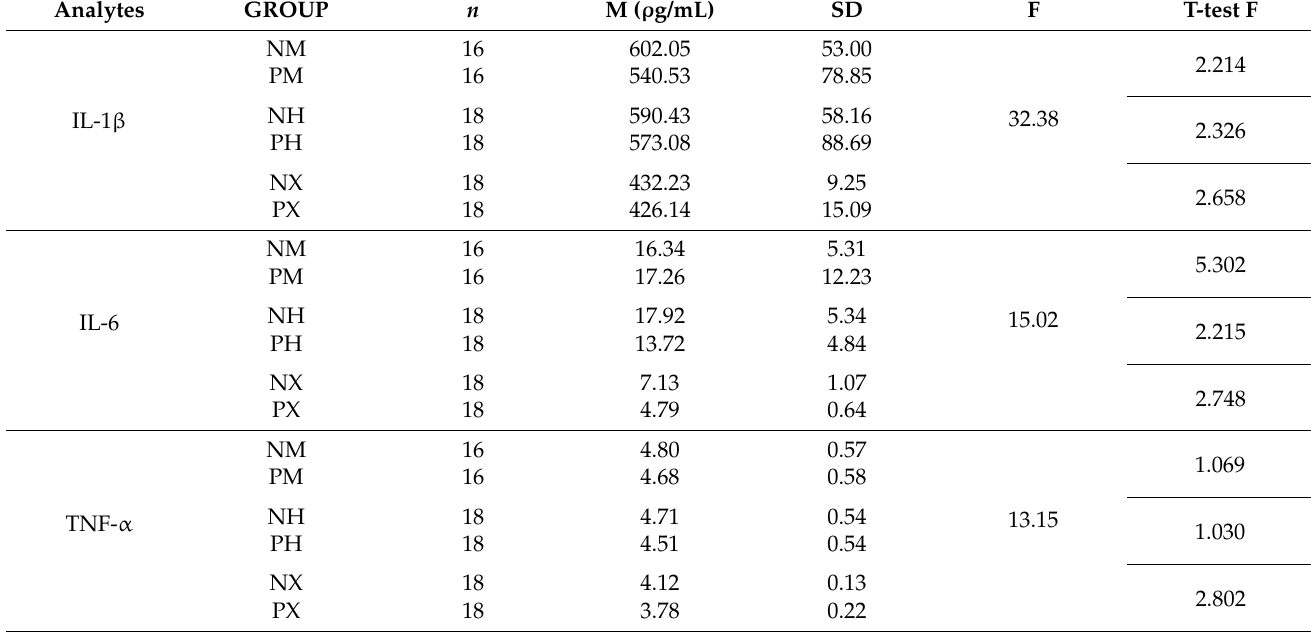
Table 3. Statistical values of cytokines for the concentrations of IL-1 β (left panel), IL-6 (middle panel), and TNF- α (right panel) in cerebellar lysate from mice brains. Cytokines were detected by ELISA. Values are presented as M (mean, pg/mL) and SD (Standard Deviation). N, no probiotics; P, probiotics; M, moderate-intensity exercise; H, high-intensity exercise; X, no